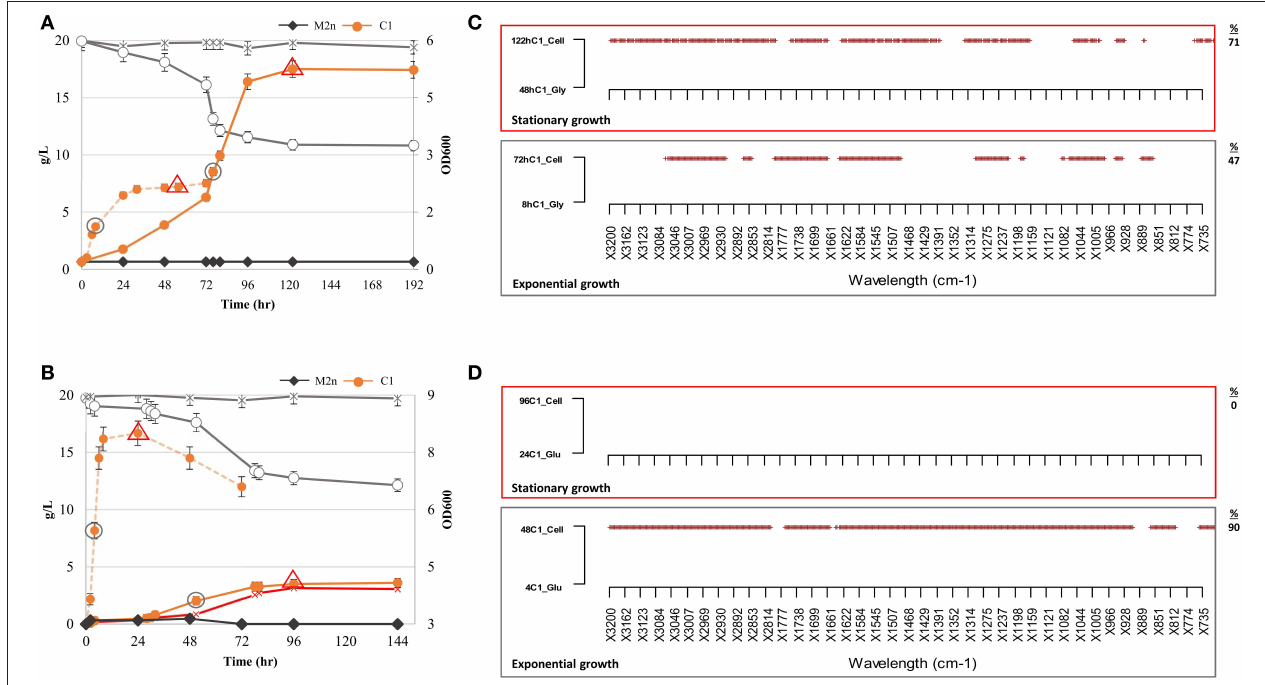
FIGURE 3 | Growth kinetics, ethanol production and metabolic variation of S. cerevisiae M2n[pBKD2- Pccbgl1 ]-C1 in cellobiose (2.05%) under aerobic and oxygen-limited conditions. (A,B) Growth kinetics (filled symbols). cellobiose consumption (g/L) (empty symbols) and ethanol production (red symbol) of C1 strain under aerobic (A) and oxygen limited conditions (B) . C1 growth in glycerol and glucose, under aerobic and oxygen limiting conditions, is reported as dashed orange line in (A,B) , respectively. The parental M2n yeast, not able to grow in cellobiose, is included as benchmark (dark gray lines). Data shown are the mean values of three replicates and relative standard errors were reported. Gray circle and red triangle symbols indicate middle-exponential and late-stationary phase samples employed for FTIR analysis. (C,D) FTIR spectroscopy assessment of biochemical variation occurring during exponential (gray box) and stationary (red box) growth in cellobiose (2.05%) under aerobic and oxygen-limited conditions. SWA analysis was carried out by comparing spectra of the C1 strain in cellobiose with those from the same physiological conditions in (C) glycerol and (D) glucose. All significant different wavelengths ( p < 0.01) are reported as red dots. The percentages (%) of spectrum wavelengths of C1 cells grown in cellobiose significantly different from those of C1 cells grown in glycerol or glucose are also